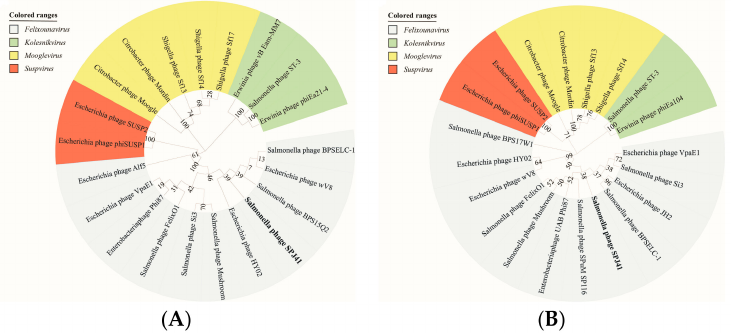
Figure 3. Phylogenetic analyses of SPJ41. ( A , B ) Phylogenetic analyses of selected phages and phages of the proposed new genus based on the protein sequence of terminase large subunit and major capsid protein. Members of the genera Felixounavirus , Kolesnikvirus , Mooglevirus, and Suspvirus virus were illustrated with sky blue, pale green, yellow, and red, respectively.